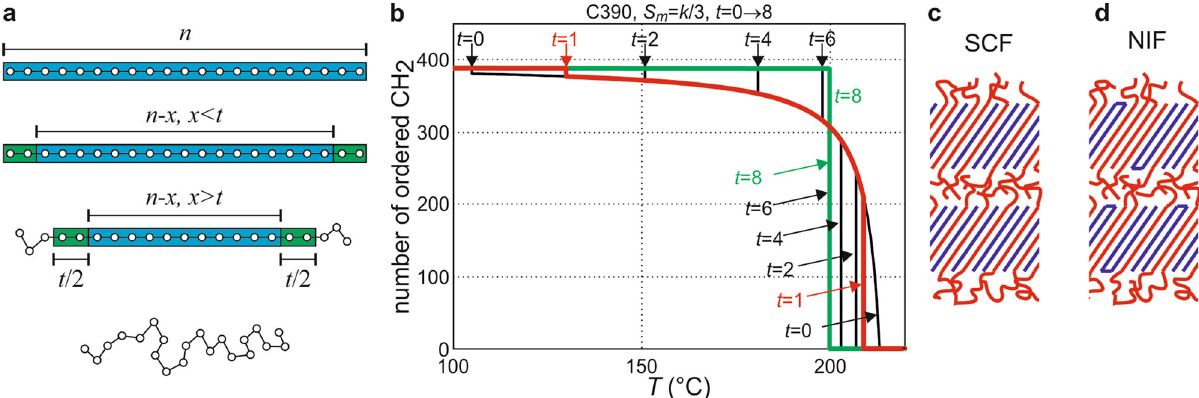
Fig. 5 Mean- fi eld theory and prediction of continuous melting. a Schematic models of chains in different states. Top to bottom: fully crystalline, no surface disorder; smooth surface with small premelting/surface disorder, x < t ; rough surface with signi fi cant premelting, x > t ; and melt. b Number of CH 2 groups remaining in the ordered middle of the lamellae (proportional to crystallinity), calculated for transition layer thickness t from 0 to 8. The temperature of the transition from smooth to rough surface (the small downward step in crystallinity) increases with increasing t , while the melting temperature of the lamellae (the fi nal jump to 0 crystallinity) decreases. Consequently the temperature range of the rough surface and of partial melting becomes narrower, until for t = 8 it disappears completely. c Semicrystalline form (SCF) can be thermodynamically stable in binary mixtures of ultra-long n-alkanes with only the chain ends of the longer alkane melted (shorter alkane molecules are colored blue and longer alkane red) 34 . d Tight chain folding and tilting are needed to alleviate overcrowding and allow growth of metastable semicrystalline NIF lamellae in pure ultra-long alkanes (folded chain colored blue and non-folded red) 36